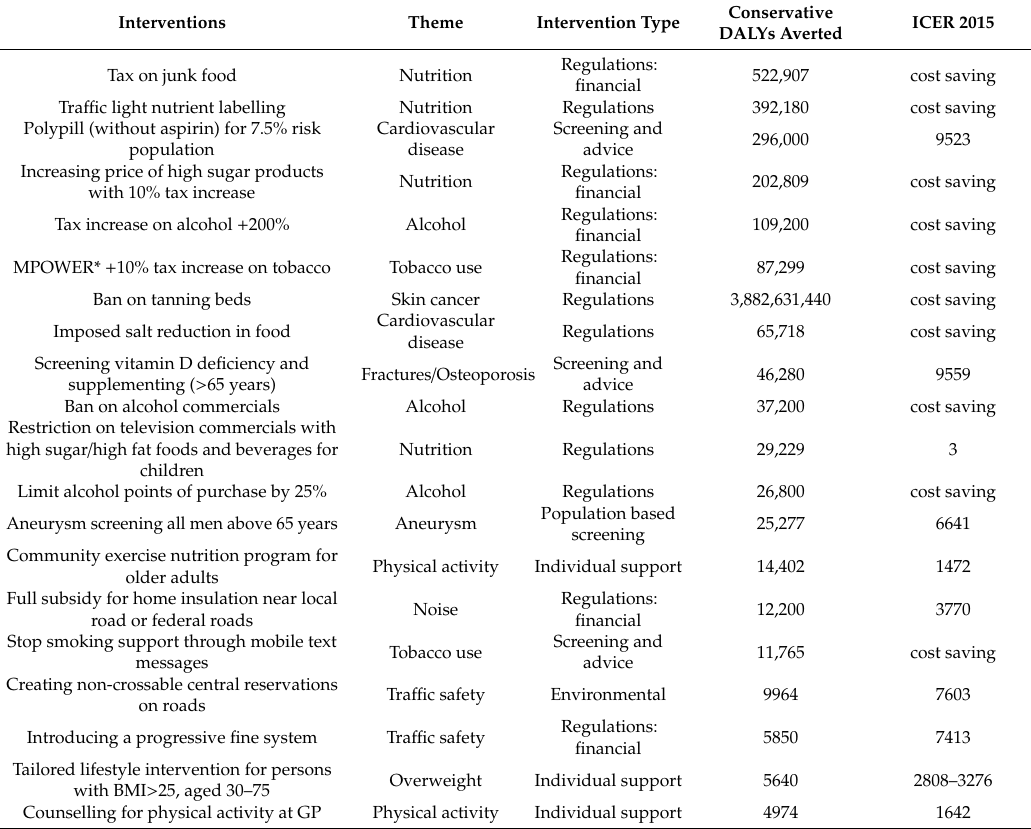
Table 4. Ranking of the top 20 highest Conservative Averted DALYs (CAD), ranked from highest CAD to lower CAD (from the total of 51